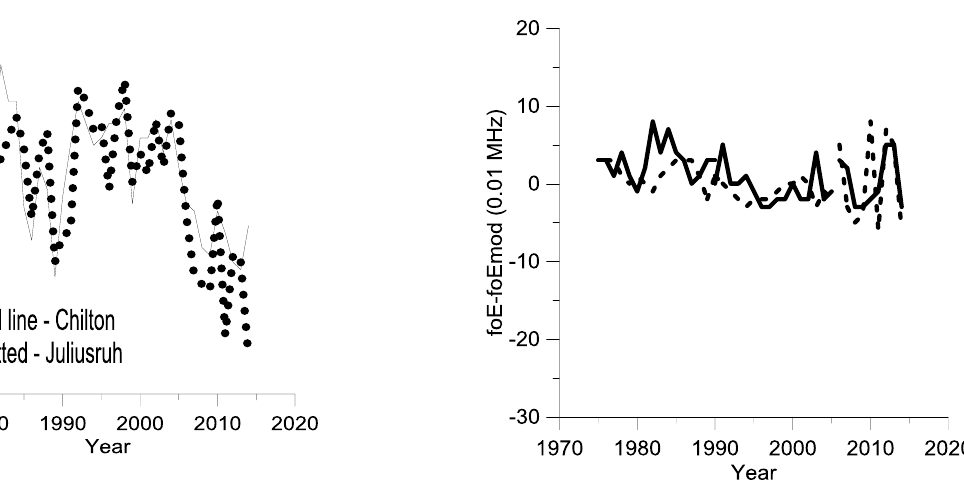
Figure 1. Residuals (cid:49) fo E (0.01MHz) after removal of solar activity (F10.7) influence (Eq. 1), yearly values, for Chilton (full line) and Juliusruh (dotted line).